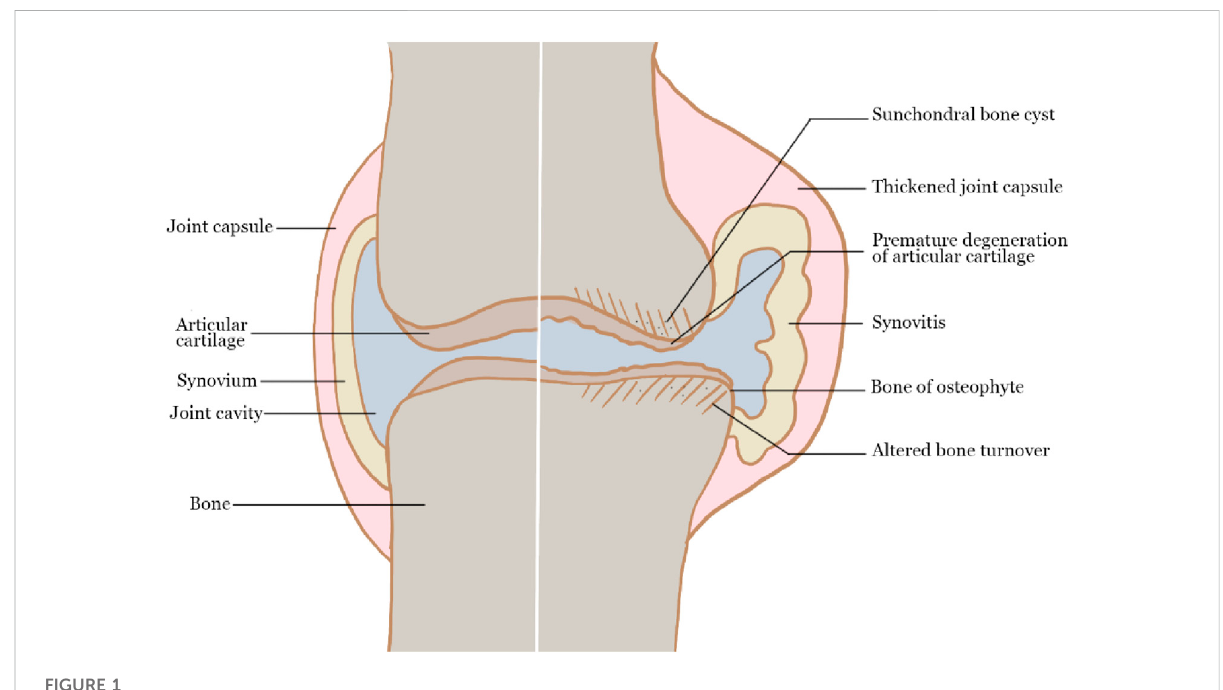
FIGURE 1 The pathophysiology of